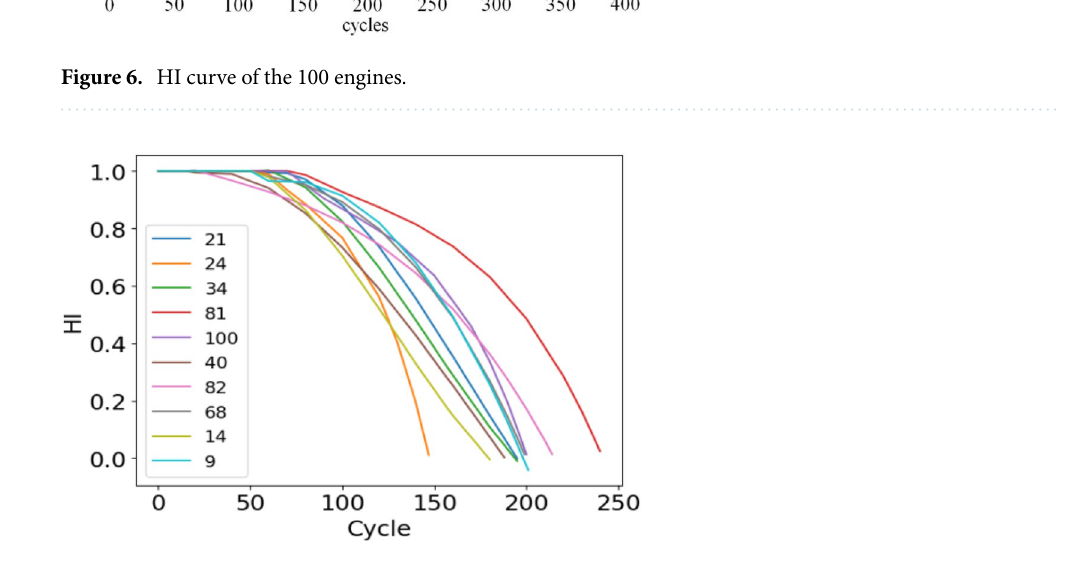
Figure 7. 10 HI curve of the training